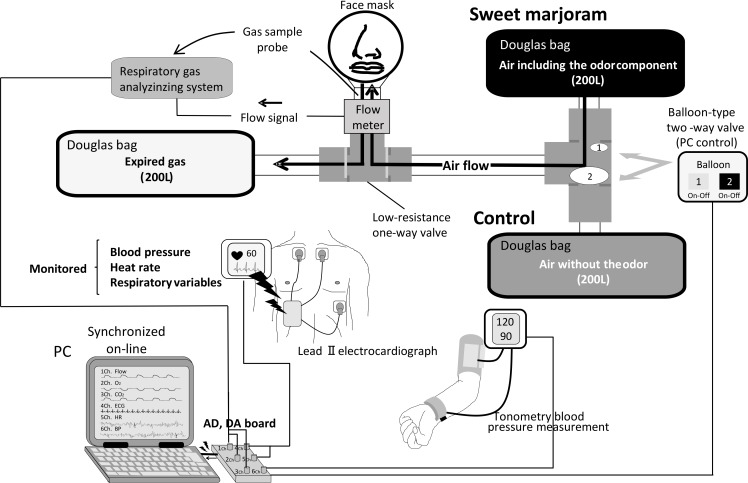
Experimental set up.